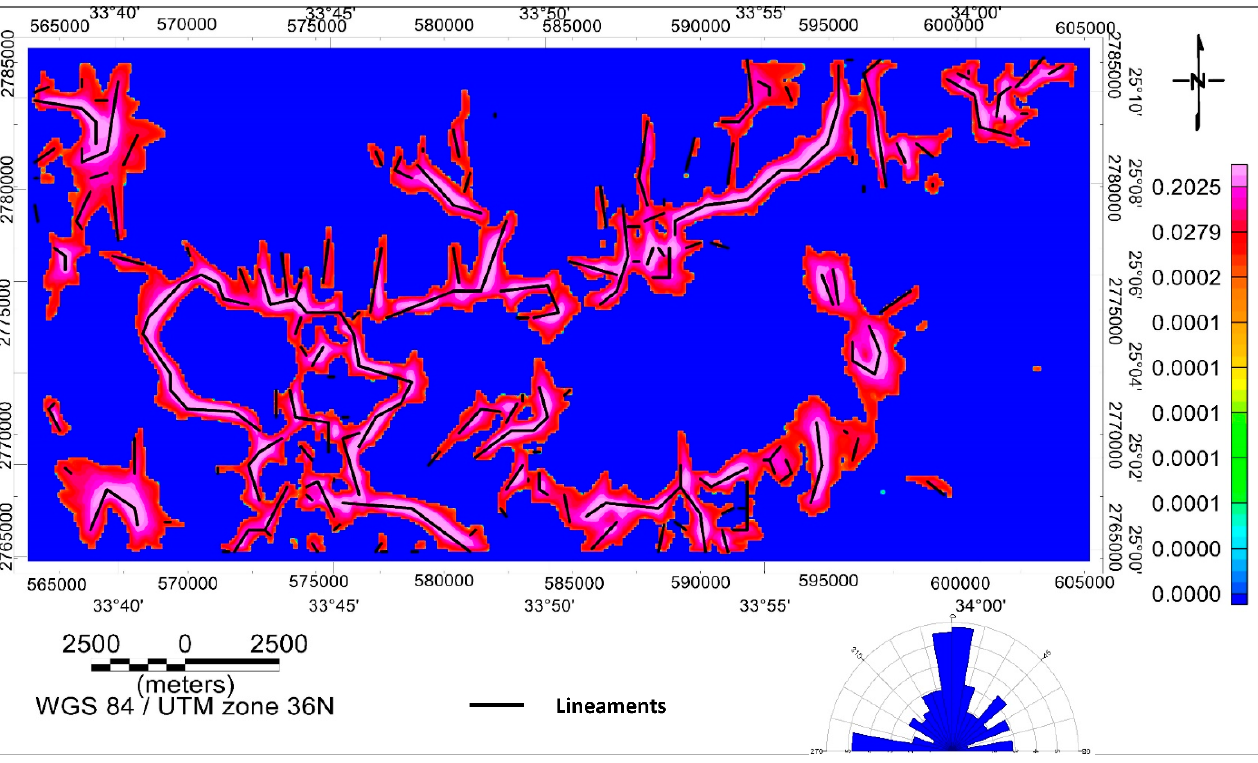
Figure 9. Phase symmetry map; black lines interpreted as faults by the CET grid. Insert showing rose diagram.